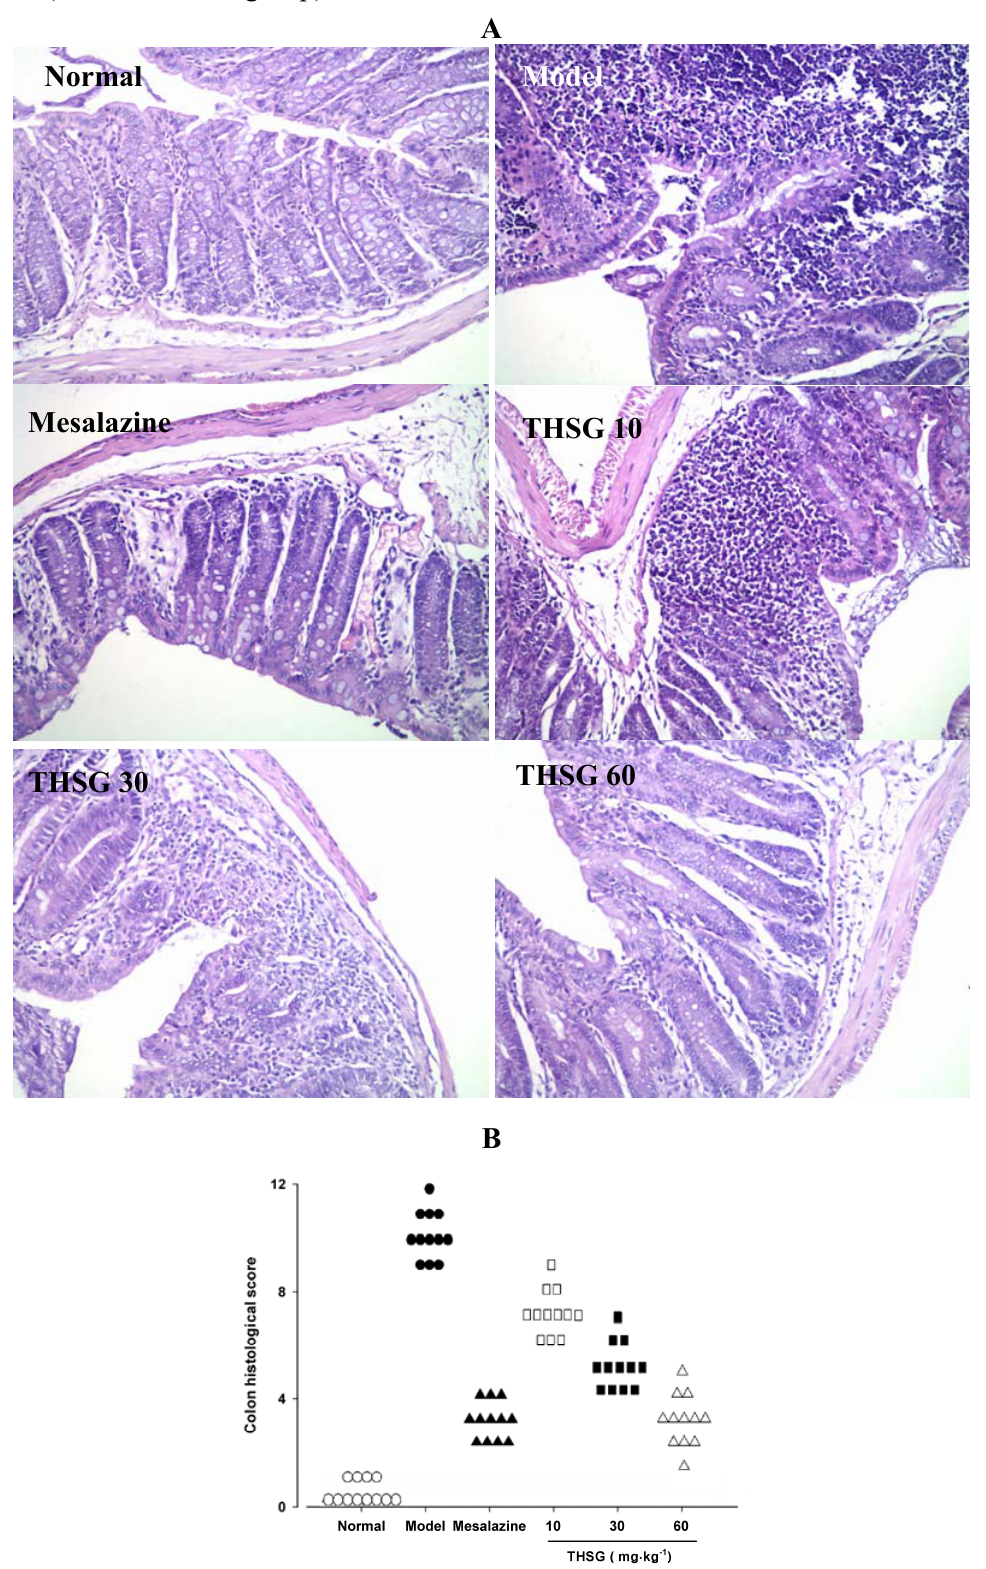
Figure 3. Beneficial effects of THSG on experimental colitis induced by acetic acid in mice ( A ) Representative slides of haematoxylin and eosin (H & E) stain (magnification 200 ×). ( B ) The histological scores derived from histopathologic evaluation of colon in mice. (n = 12 for each